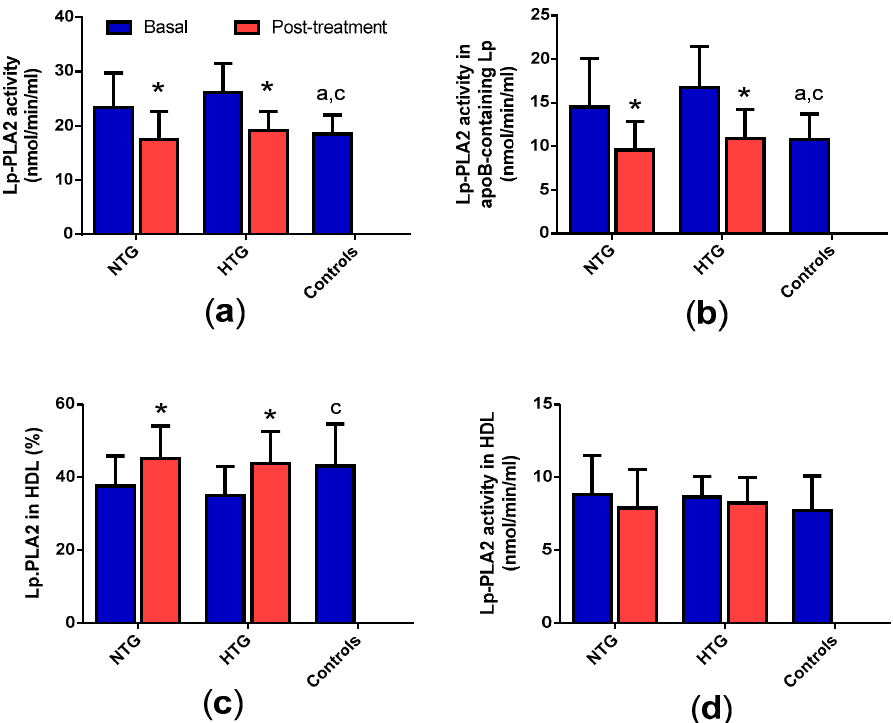
Figure 1. Total Lp-PLA 2 activity and distribution in lipoproteins. ( a ) Total activity; ( b ) and ( d ): Activity associated to apoB-lipoproteins and high-density lipoprotein (HDL), respectively; ( c ) proportion of activity associated to HDL. Data are expressed as mean ± SD. * p < 0.05 vs. basal samples. a p < 0.05 vs. basal NTG. b p < 0.05 vs. NTG post-treatment. c p < 0.05 vs. basal HTG. d p < 0.05 vs. HTG post-treatment.